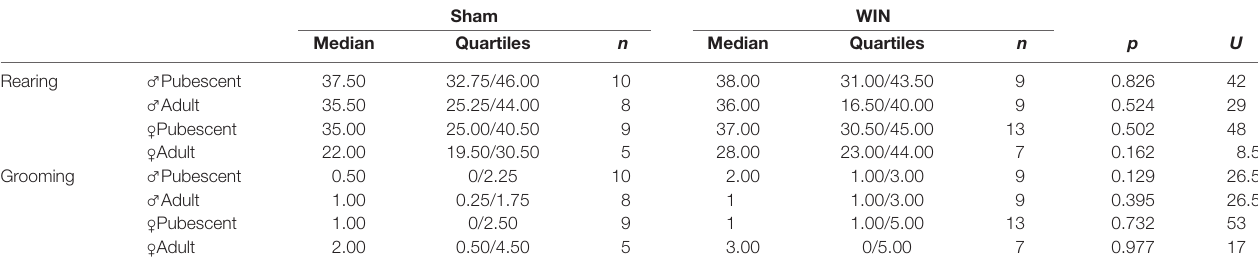
WIN: t ( 4 ) = 3.190, p = 0.033; Paired t -test). Similar results were observed in adult males with or without prior in vivo cannabinoid exposure ( Figure 5B : Sham, t ( 6 ) = 3.116, p = 0.020; WIN, t ( 6 ) = 2.787, p = 0.031; Paired t -test). In the male rat PFC, eCB-LTD is not affected 24 h after in vivo cannabinoid obtained from female rats in both age groups. Figure 5C shows the lack of LTD in PFC slices from cannabinoid-treated pubescent (Sham, t ( 4 ) = 5.021, p = 0.007; WIN, t ( 4 ) = 1.129, p = 0.322; paired t -test) and adult female rats ( Figure 5D : Sham, t ( 4 ) = 2.979, p = 0.040; WIN, t ( 7 ) = 1.003, p = 0.349; paired t -test).